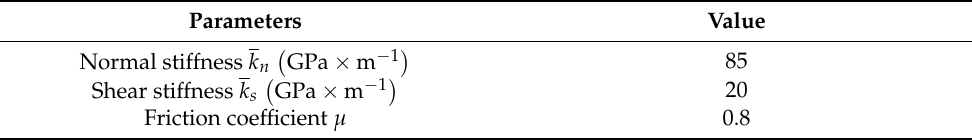
Table 3. Microparameters of the smooth-joint (S-J) model.